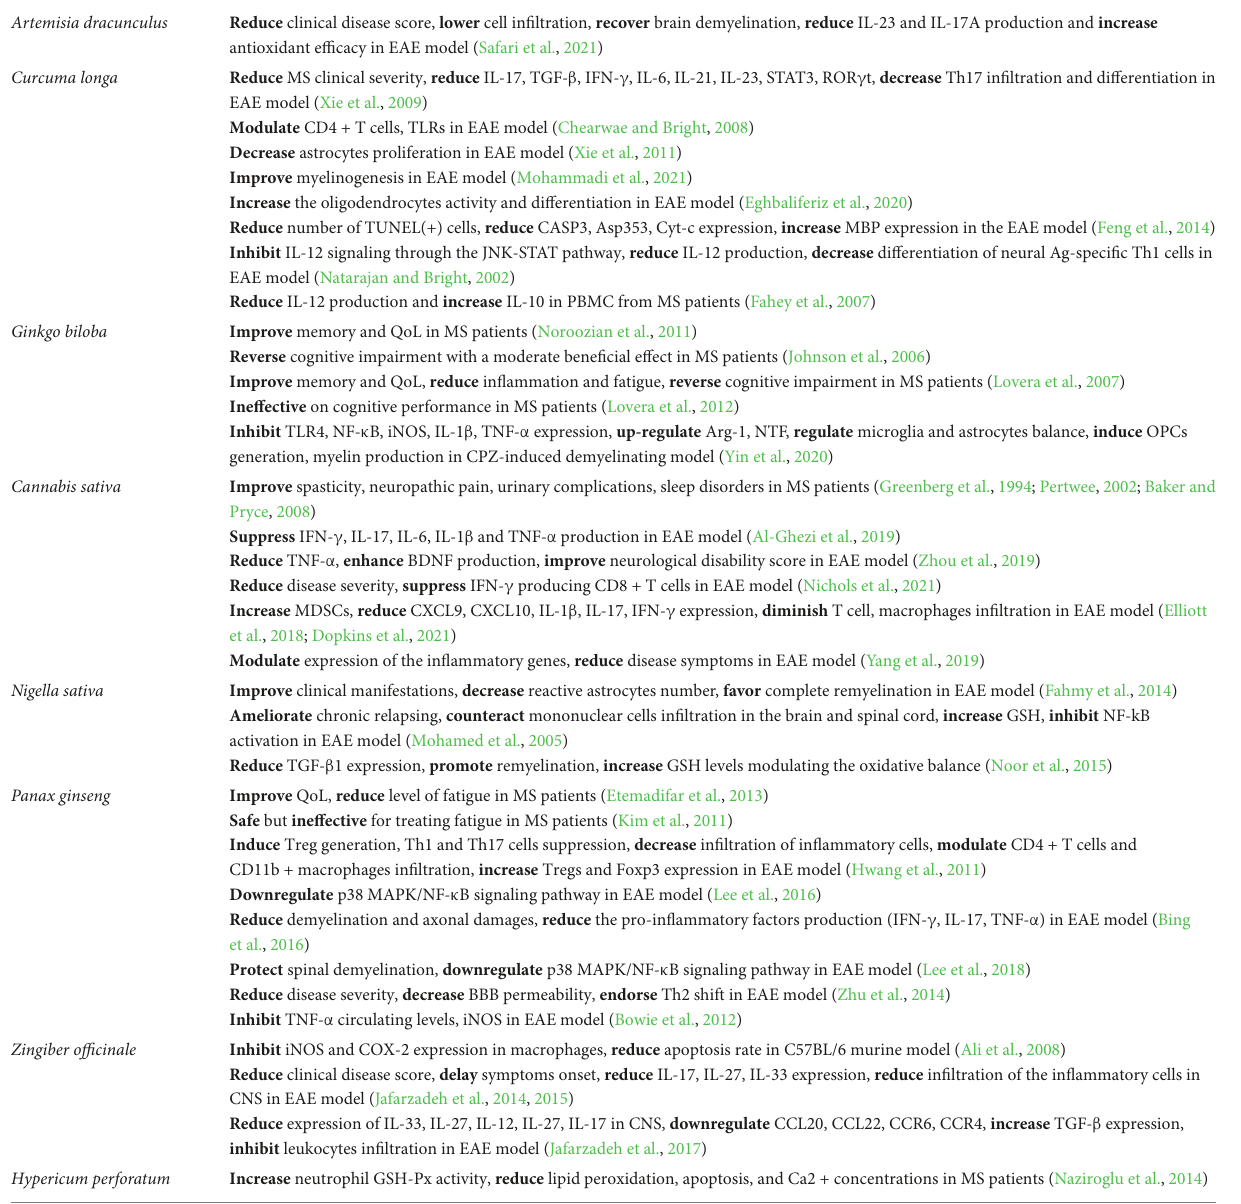
TABLE 1 Summary of herbal medicines with therapeutic effects on MS patients and EAE models. Medicinal